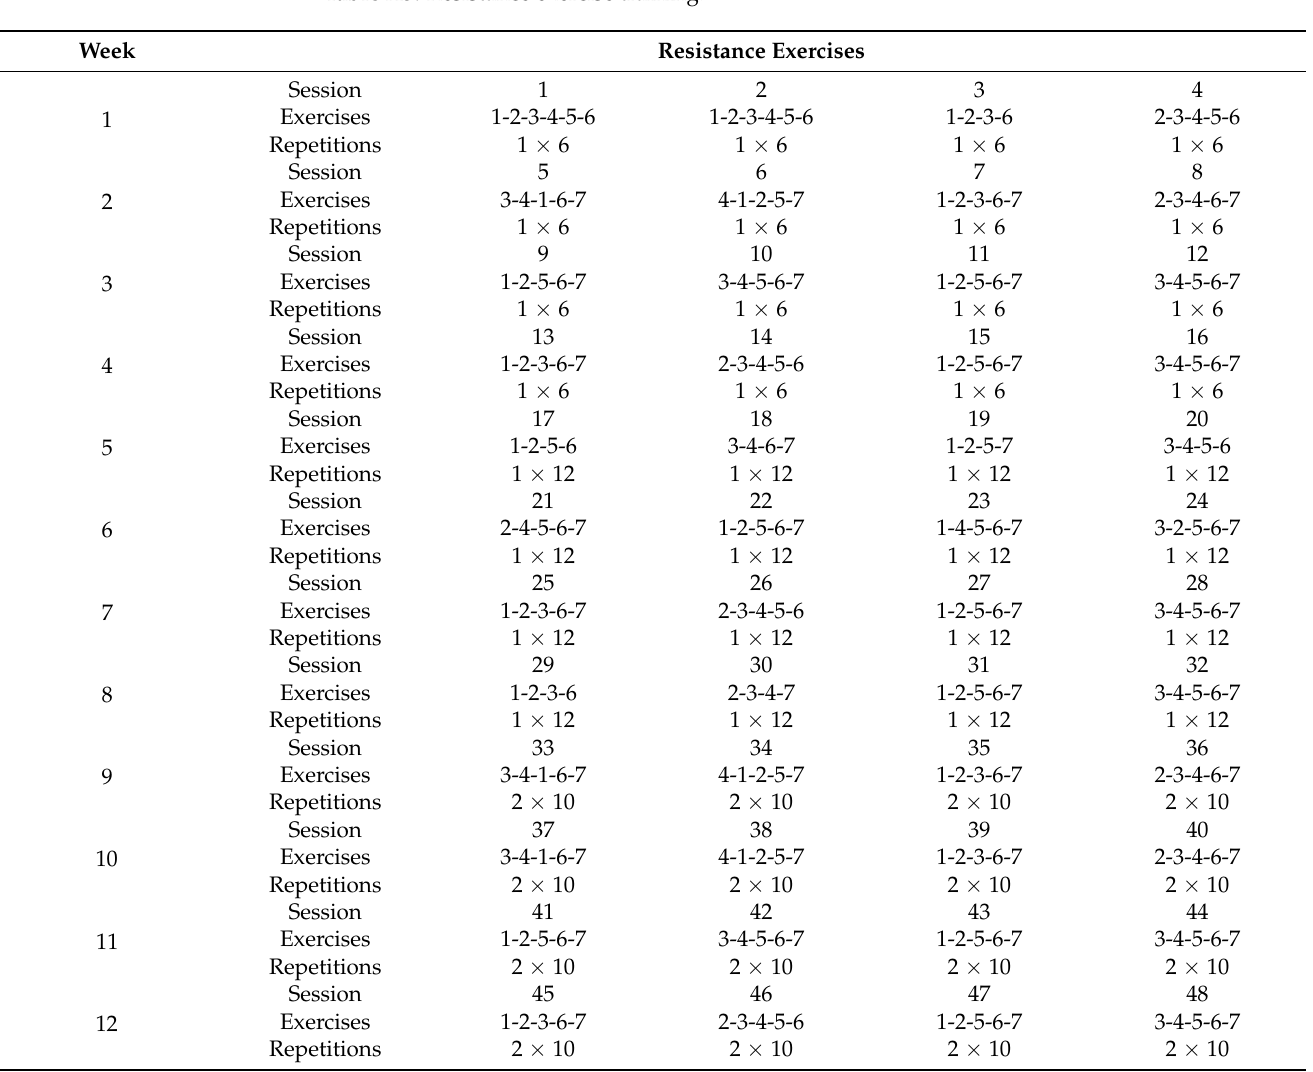
Table A3. Resistance exercise